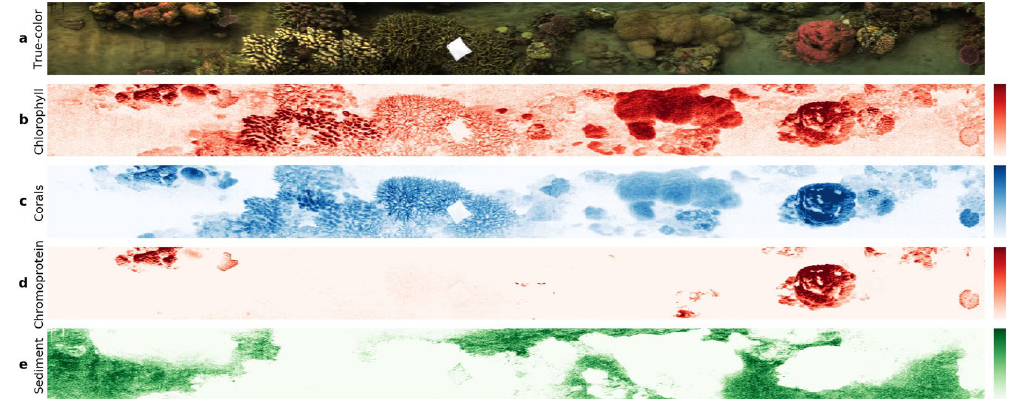
Figure 3. Semi-quantitative spectrometric maps generated from the transect scene shown in ( a ). Derivative analysis of the reflectance spectra was used to create abundance/discriminant maps of chorophyllic photopigments ( b ), coral substrata ( c ), coral chromoproteins ( d ) and sediments (phycoerythrin) ( e ). Color intensity reflects the value of the calculated spectrometric indices for the